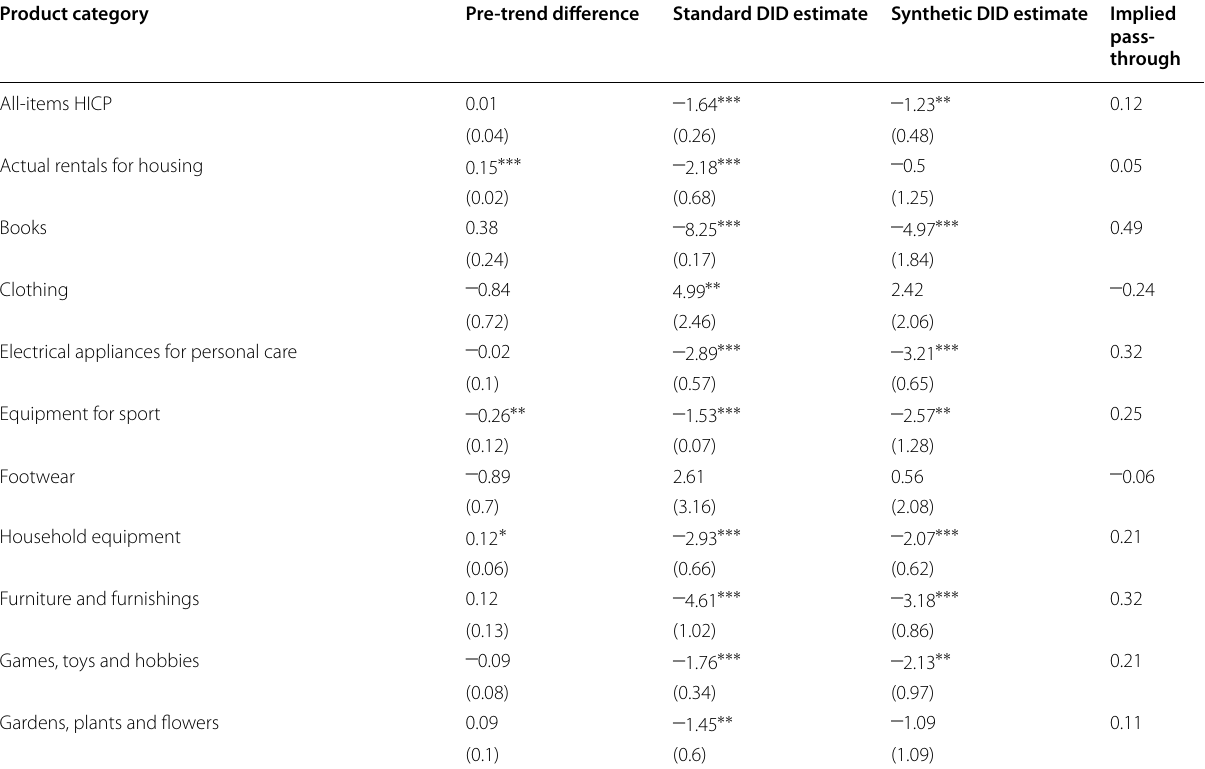
Table 6 Estimates of the exchange rate pass-through to consumer prices for Household